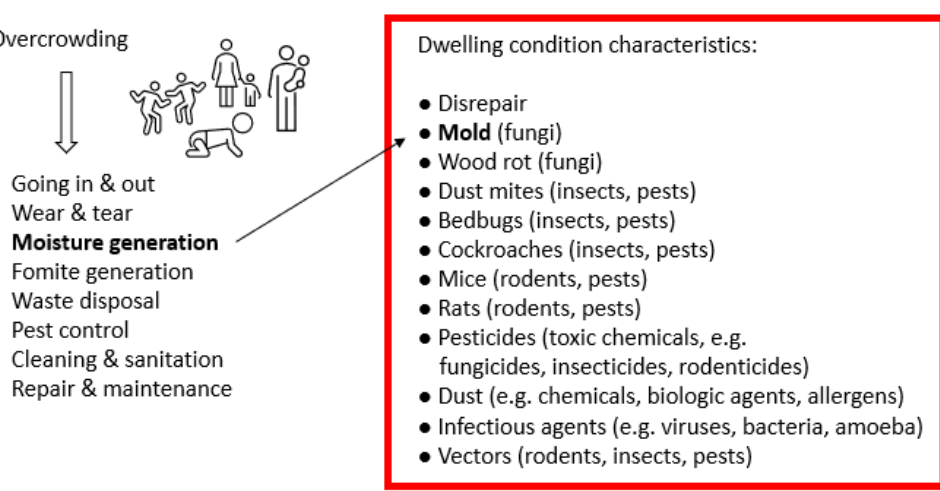
Figure 3. Extracted dwelling condition characteristics that may potentially be due to overcrowding and are of relevance for health. The bold text and thin arrow highlight one of the relations, in this case, that too many residents can lead to excess moisture generation and mold.